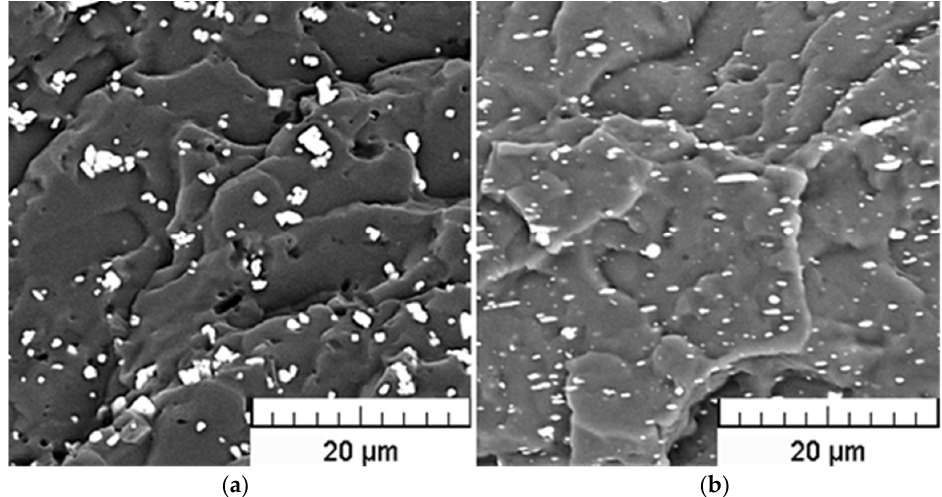
Figure 4. SEM pictures of the cross-sections of 17Ba ( a ) and 10Bi ( b ) samples.